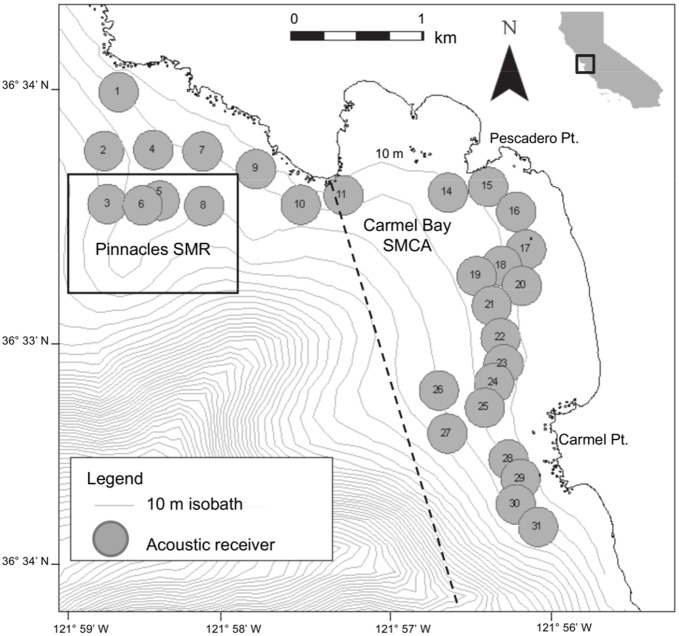
Study location in Carmel Bay with Marine Protected Area boundaries and receiver locations.Dashed line indicates the State Marine Conservation Area (SMCA). Solid line surrounds the State Marine Reserve (SMR). Numbered grey circles represent receiver locations with estimated 150 m radius. Depth contours are based on 10 m isobaths.